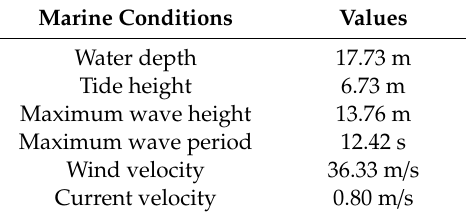
Figure 4. Selected site of southwest coast in Korea [30]. Table 1. Marine conditions in